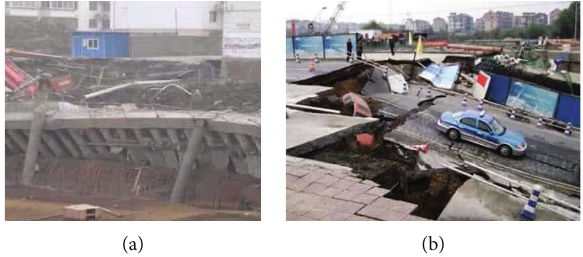
Figure 1: Typical foundation pit excavation accidents. (a) Foundation pit collapse accident in Suzhou in 2008. (b) Foundation pit collapse accident in Hangzhou in